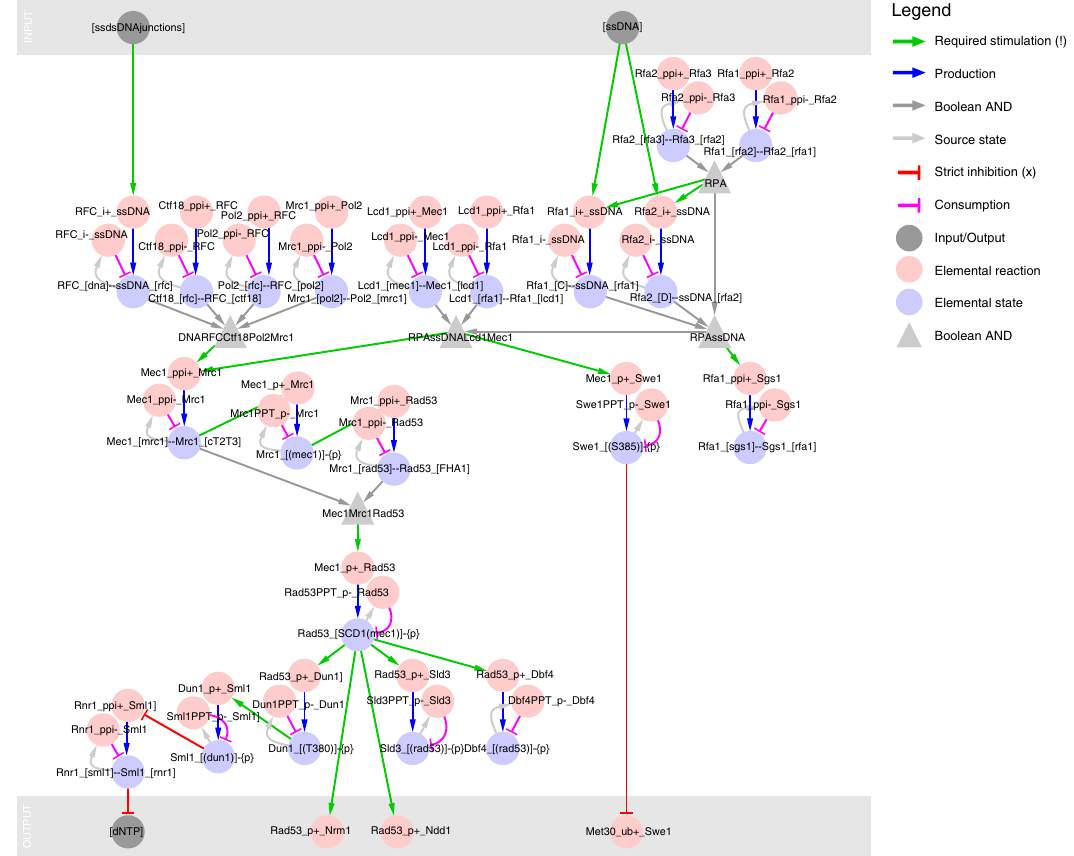
Fig. 3 The Mec1/Rad53 pathway senses ongoing DNA replication to inhibit mitotic entry. Ongoing DNA replication leads to exposed ssDNA and ssDNA/ dsDNA junctions at the replication forks, which are sensed by the Mec1/Rad53 pathway, activating dNTP synthesis, stabilising S-phase gene expression through inhibition of Nrm1, and preventing mitotic entry through inhibition of Ndd1 and stabilisation of Swe1. The presence of ssDNA and ssDNA/dsDNA junctions allows the assembly of the ssDNA-RPA-Lcd1-Mec1 (right) and DNA-RFC-Ctf18-Pol2-Mrc1 (left) complexes, respectively. The complexes are de fi ned through (nested) Boolean AND gates of six and four bonds, respectively. The two complexes are thought to bring active Mec1 in proximity of Mrc1, promoting their interaction and phosphorylation of Mrc1, leading to the recruitment, phosphorylation and activation of Rad53. Active Rad53 supports DNA synthesis (through Dun1 and Sml1 mediated derepression of Rnr1) and S-phase transcription (through inhibition of Nrm1, an inhibitor of the MBF transcription factor), and prevents mitotic entry (through inhibition of Ndd1, which is needed for CLB1/2 transcription). In parallel, Mec1 prevents mitotic entry through stabilisation of Swe1, a Cdk1-Clb1/2 inhibitor. The regulatory graph is a bipartite representation where elemental reactions (red) produce or consume elemental states (blue), and elemental states in fl uence elemental reactions through contingencies. Complex contingencies are collected in Boolean nodes (AND/OR/NOT; light grey), and input/output nodes (dark grey) de fi ne the interface between the model and its surroundings — and between the MRN and CGM parts. The fi gure has been simpli fi ed by omitting domain and residue names in the reaction node